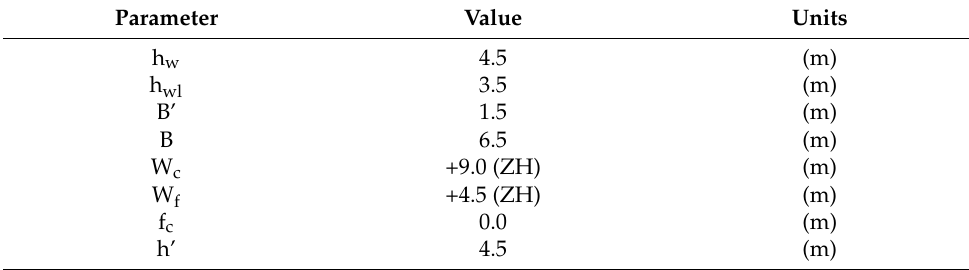
Table 4. Geometric parameters of the monolithic crown